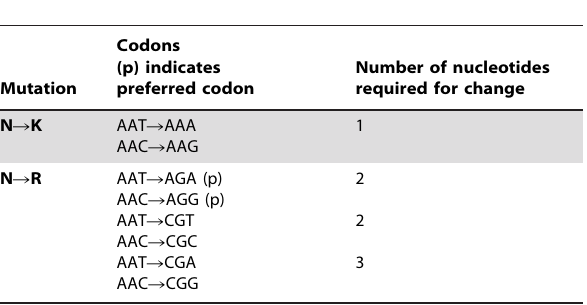
Table 3. Analysis of codons required to alter N to K or